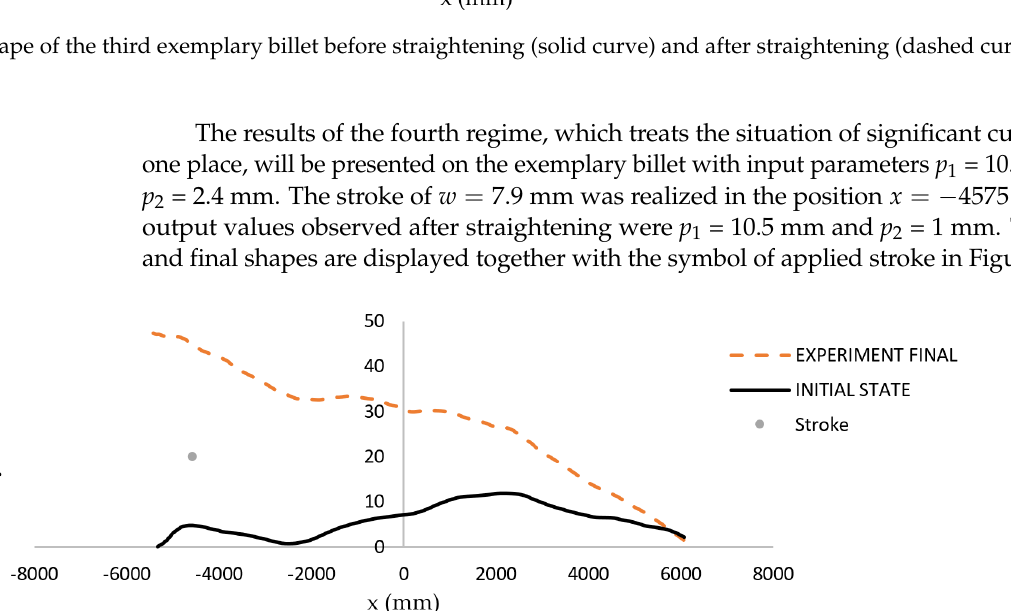
Figure 17. Shape of the third exemplary billet before straightening (solid curve) and after straightening (dashed curve) in regime 3.